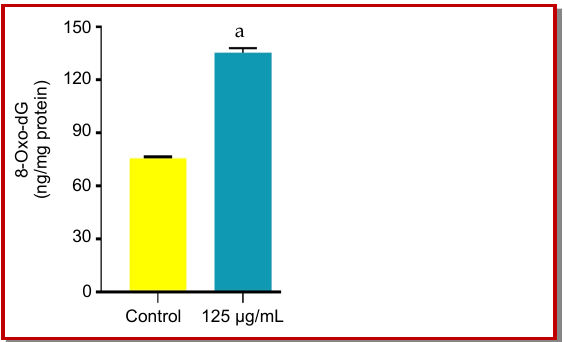
Figure 3: β -glucan (125 μ g/mL) enhanced DNA damage of SH- SY5Y cells. The 8-oxo-dG level was calculated using the ELISA kit. Results are represented as mean ± SEM of three samples. a p<0.01 as compared to the control group